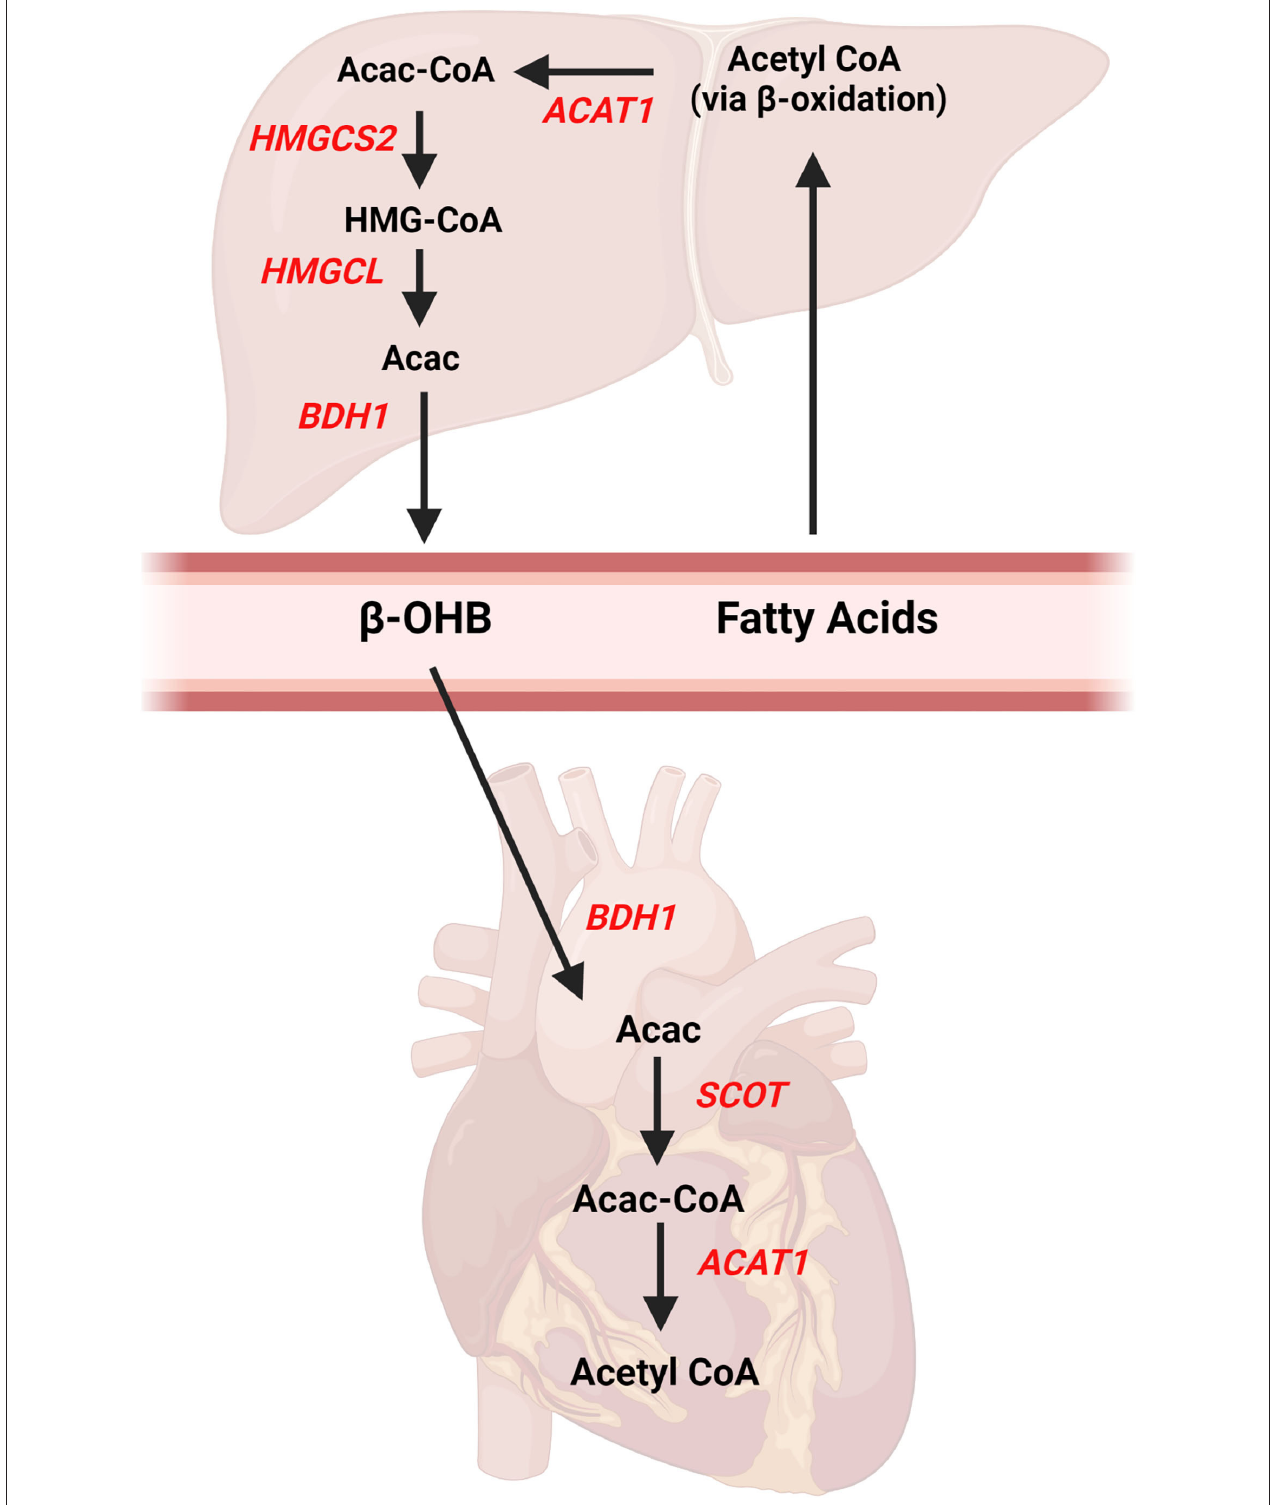
FIGURE 1 | Ketone body pathways in the liver and heart. Ketogenesis occurs primarily in the liver from fatty acids obtained from the blood. Acetyl CoA is formed from hepatic beta-oxidation and ultimately converted to beta-hydroxybutyrate ( β -OHB) via multiple enzymatic reactions. Once β -OHB enters the heart, a series of